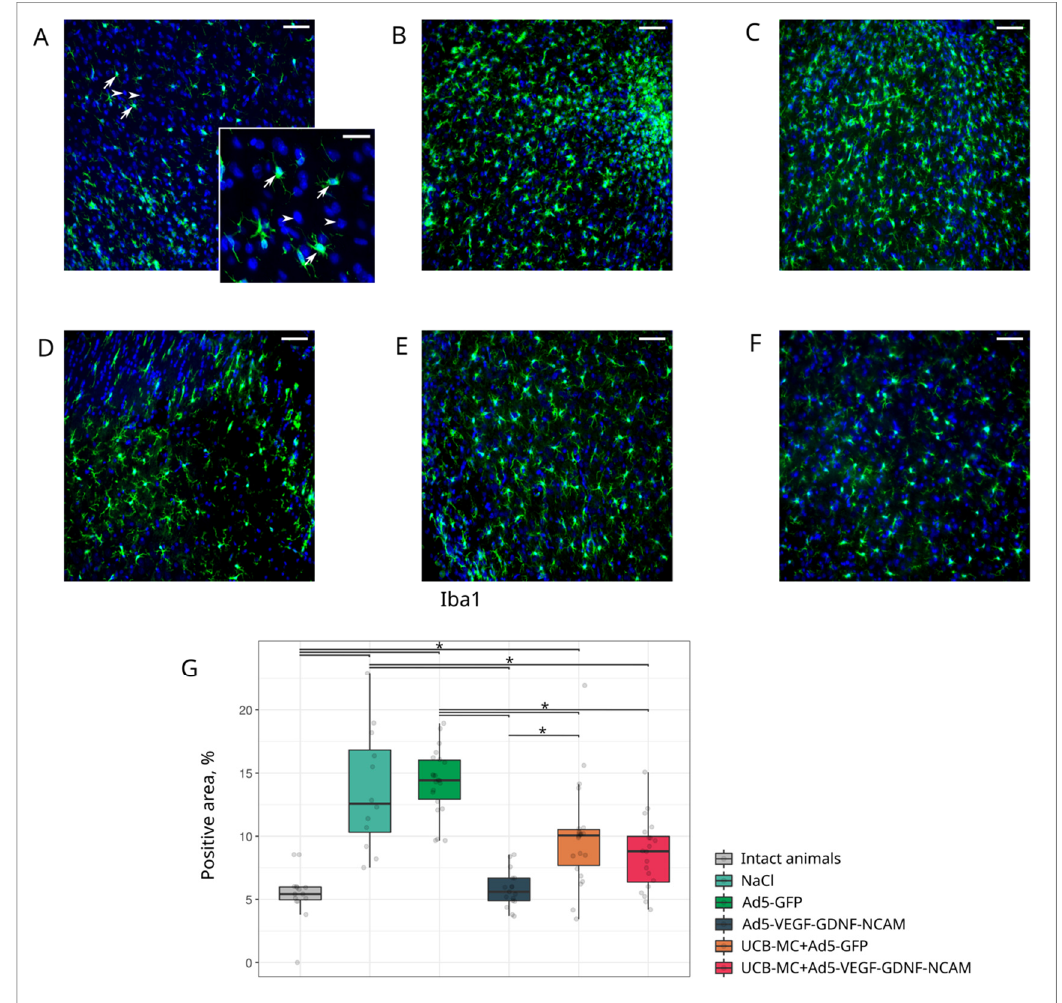
Figure 5. Immunoexpression of Iba1 in the rat brain cortex, 21 days after the middle cerebral artery occlusion. Immunofluorescent staining with antibody to microglia specific calcium-binding protein Iba1 in intact ( A ), control NaCl ( B ) and Ad5-GFP ( C ), and therapeutic UCB-MC+Ad5-GFP ( D ), Ad5-VEGF-GDNF-NCAM ( E ), and UCB-MC+Ad5-VEGF-GDNF-NCAM ( F ) groups. Arrows indicate cytoplasmic localization of Iba1 (green glow) in microglial cells. Arrowheads point to cell nuclei visualized using DAPI (blue glow). Scale bar in ( A – F ) = 50 µ m; scale bar in the insert = 20 µ m. ( G )—comparative analysis of Iba1-positive areas in experimental groups; *— p <